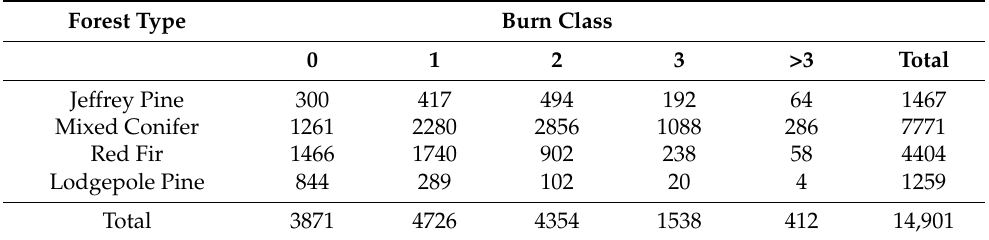
Table 1. Sample size within each forest type and burn